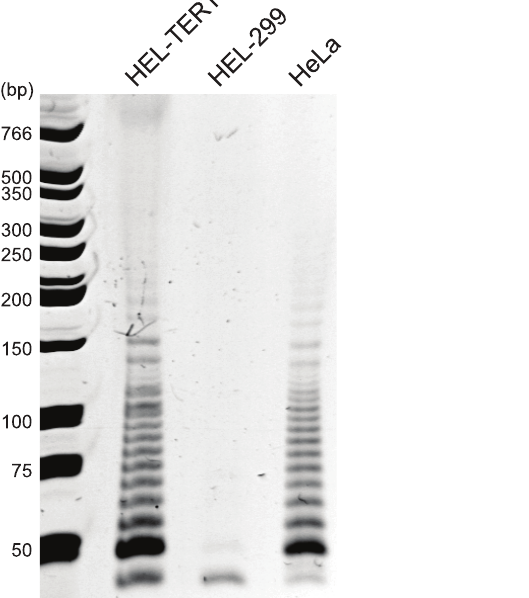
Figure 2. Telomerase activity is detectable in HEL-TERT and HeLa cells but not HEL-299 cells. HEL-299 (3 population doublings), HEL-TERT (3 population doublings), and HeLa cells were examined for telomerase activity using the TRAP assay. HeLa cells were used as a positive control for telomerase activity. The numbers at the left side of the figure are DNA size markers (bp: base pair).